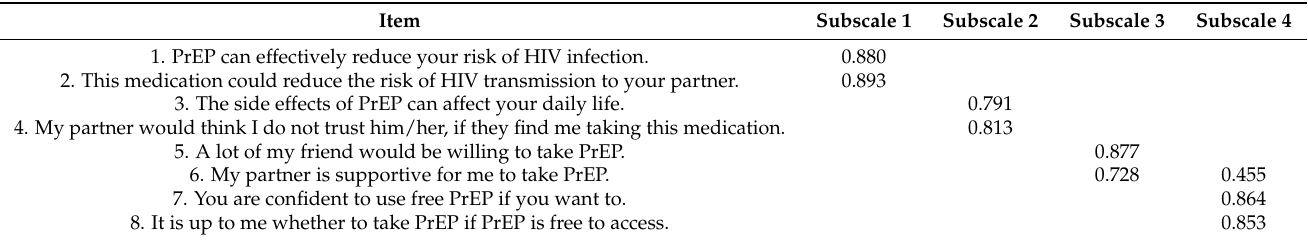
Table 4. Exploratory factor analysis of the PrEP adherence